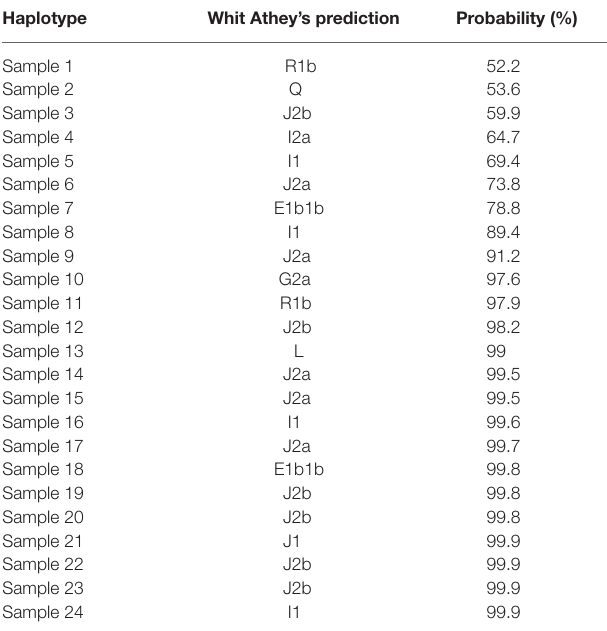
TABLE 1 | The list of haplotypes for which Y haplogroup prediction accuracy was lower than 100%. Haplotype Whit Athey’s prediction Probability